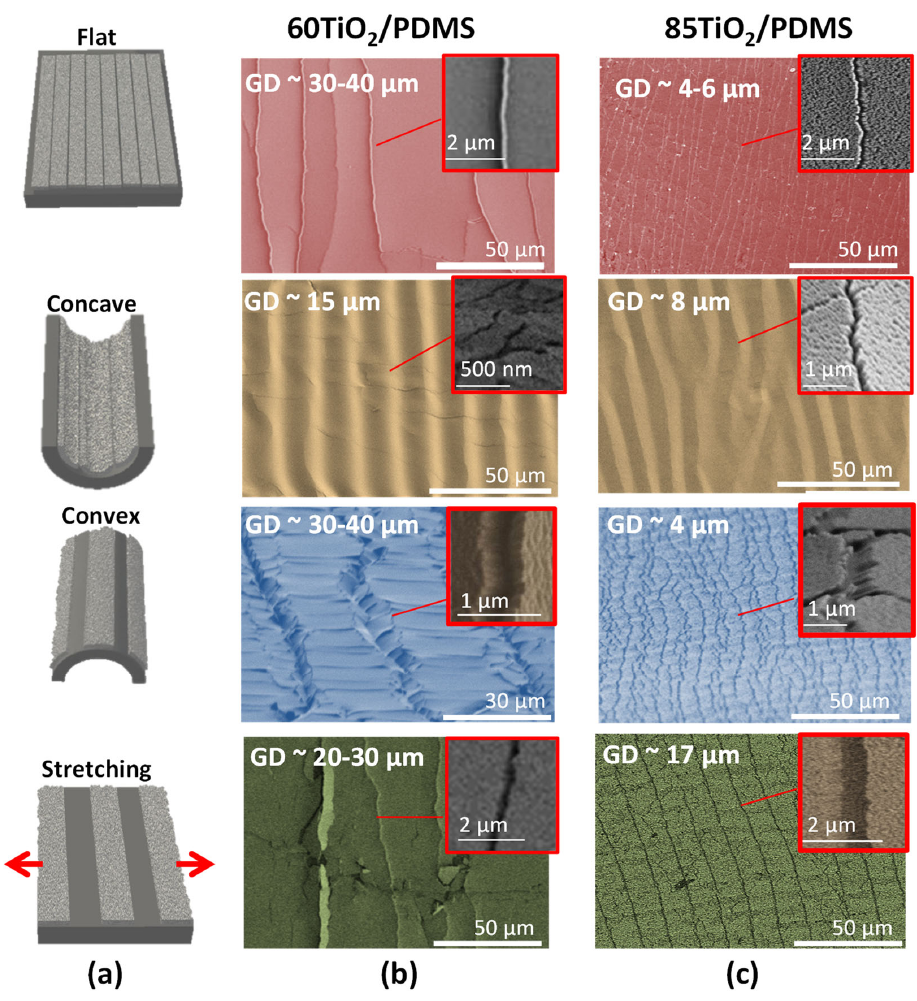
Figure 1. SEM analysis of the surface state of TiO 2 /PDMS samples subjected to different deformations after a first activation event by bending or stretching. ( a ) Schematic representation of the different configurations used to take the FESEM im ‐ ages; ( b , c ) FESEM micrographs of 60° ‐ TiO 2 /PDMS (middle) and 85° ‐ TiO 2 /PDMS surfaces (right). From top to bottom: (i) surface images of activated samples in a flat configuration after a first activation by bending; (ii,iii) concave and convex configurations during activation by bending and (iv) stretched samples in a flat configuration. The insets show magnified views of the groove regions. GD: average groove distance, as measured in the